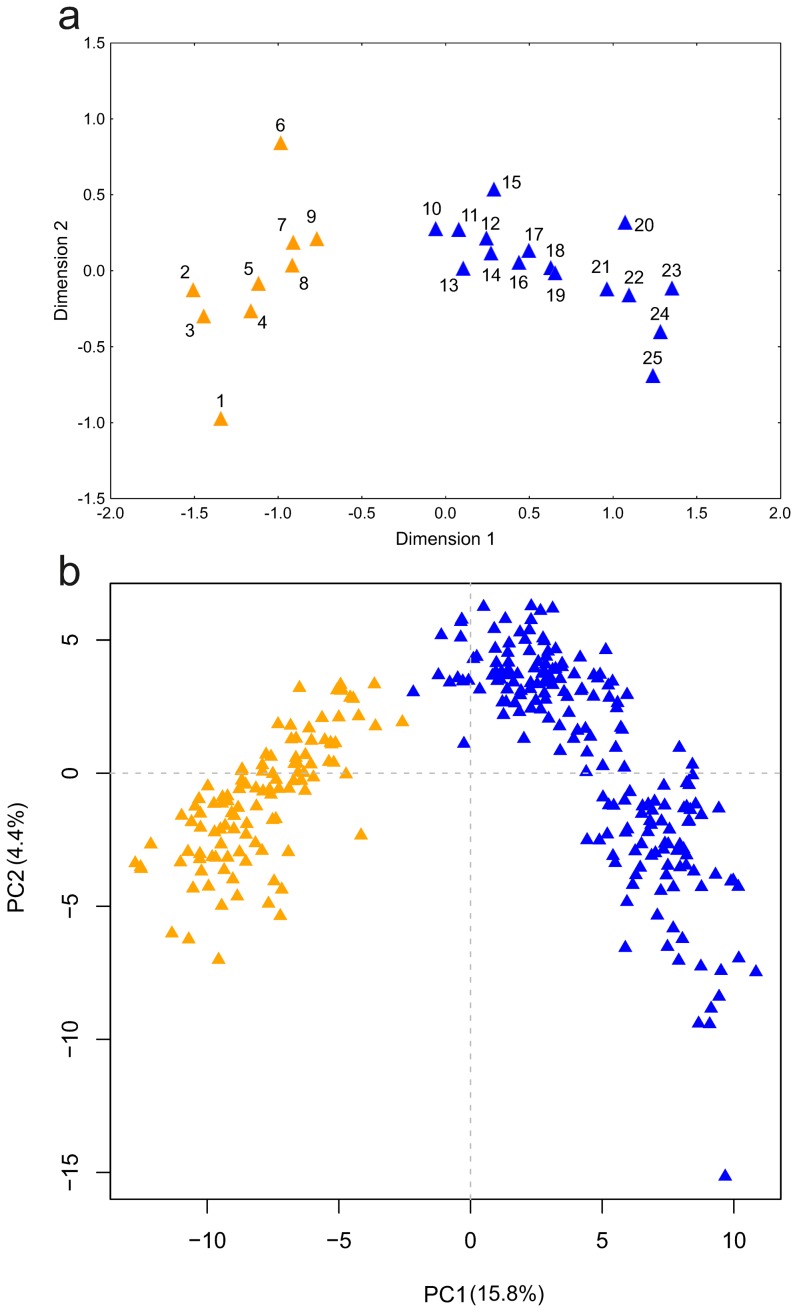
Genetic differentiation within L. montandoni.(a) Non-metric two-dimensional scaling of the pairwise F
ST matrix; orange – populations from the northern group; blue – populations from the southern group; (b) Principal Component Analysis (PCA) performed on individual genotypes; in parentheses percentage of variance explained by principal components; orange – individuals from the northern group; blue – individuals from the southern group.